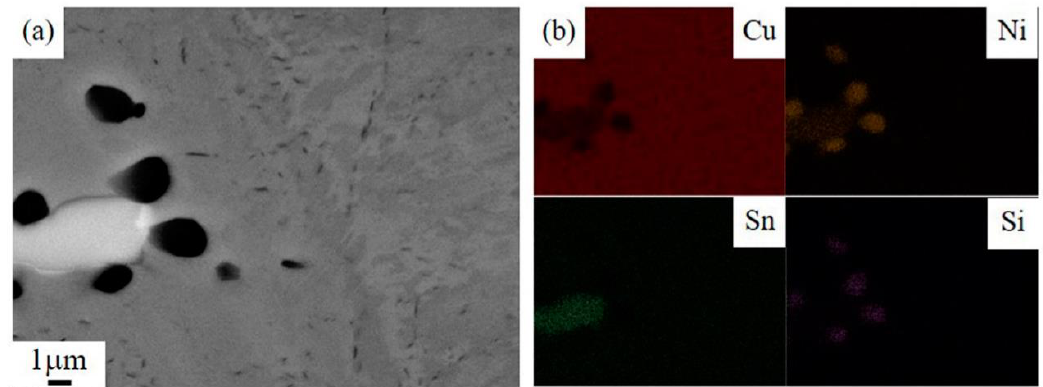
Figure 5. The element distribution state of the as-cast sample of the Cu–6Ni–6Sn–0.6Si alloy: ( a ) image of particles, ( b ) EDS-mapping of Cu, Ni, Sn, Si element.